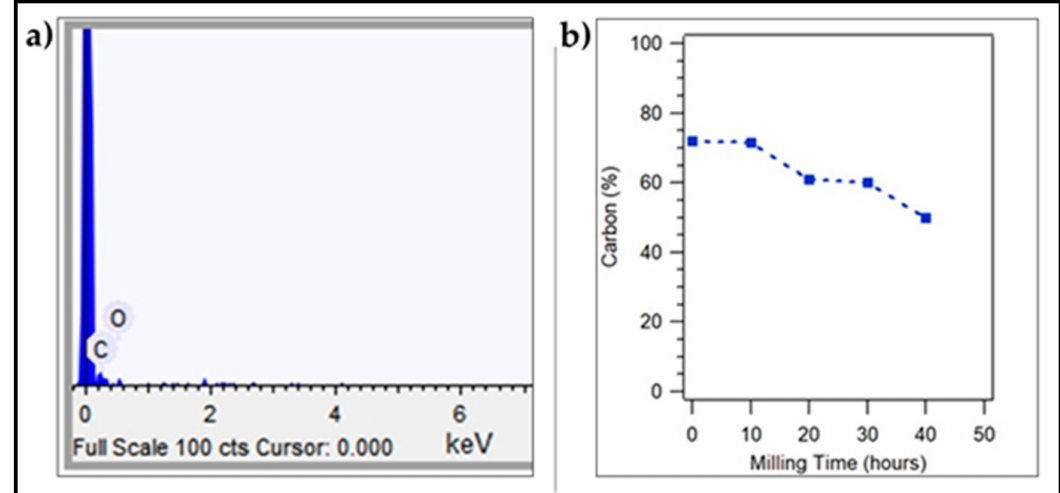
Figure 4. ( a )SEM-EDSspectrumofcoconutshellparticles,( b )percentageofcarbonincoconutshellparticles. Selected area electron di ff raction (S.A.E.D.) of coconut shell particles was also